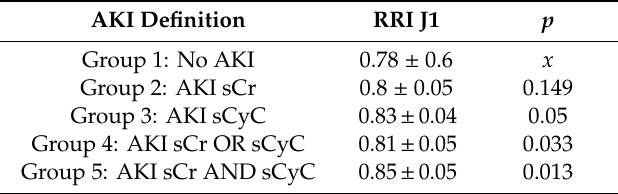
Figure 2. Receiver-Operating Characteristic (ROC) Curve Displaying the Optimal Threshold and Goodness of Renal Resistive Index one day after TAVR for sCyC AKI. Renal Resistive Index one day after TAVR provides a good prediction of sCyC AKI with an optimal cutoff value of 0.795 and an area under the curve of 0.766. AUC = 0.766; Confidence interval (0.618; 0.913, p = 0.006); Optimal RRI threshold = 0.795 (Se 80%; 1-Sp 0.378). Table 6. Renal Resistive index (RRI) values one-day after TAVR according to AKI definitions.